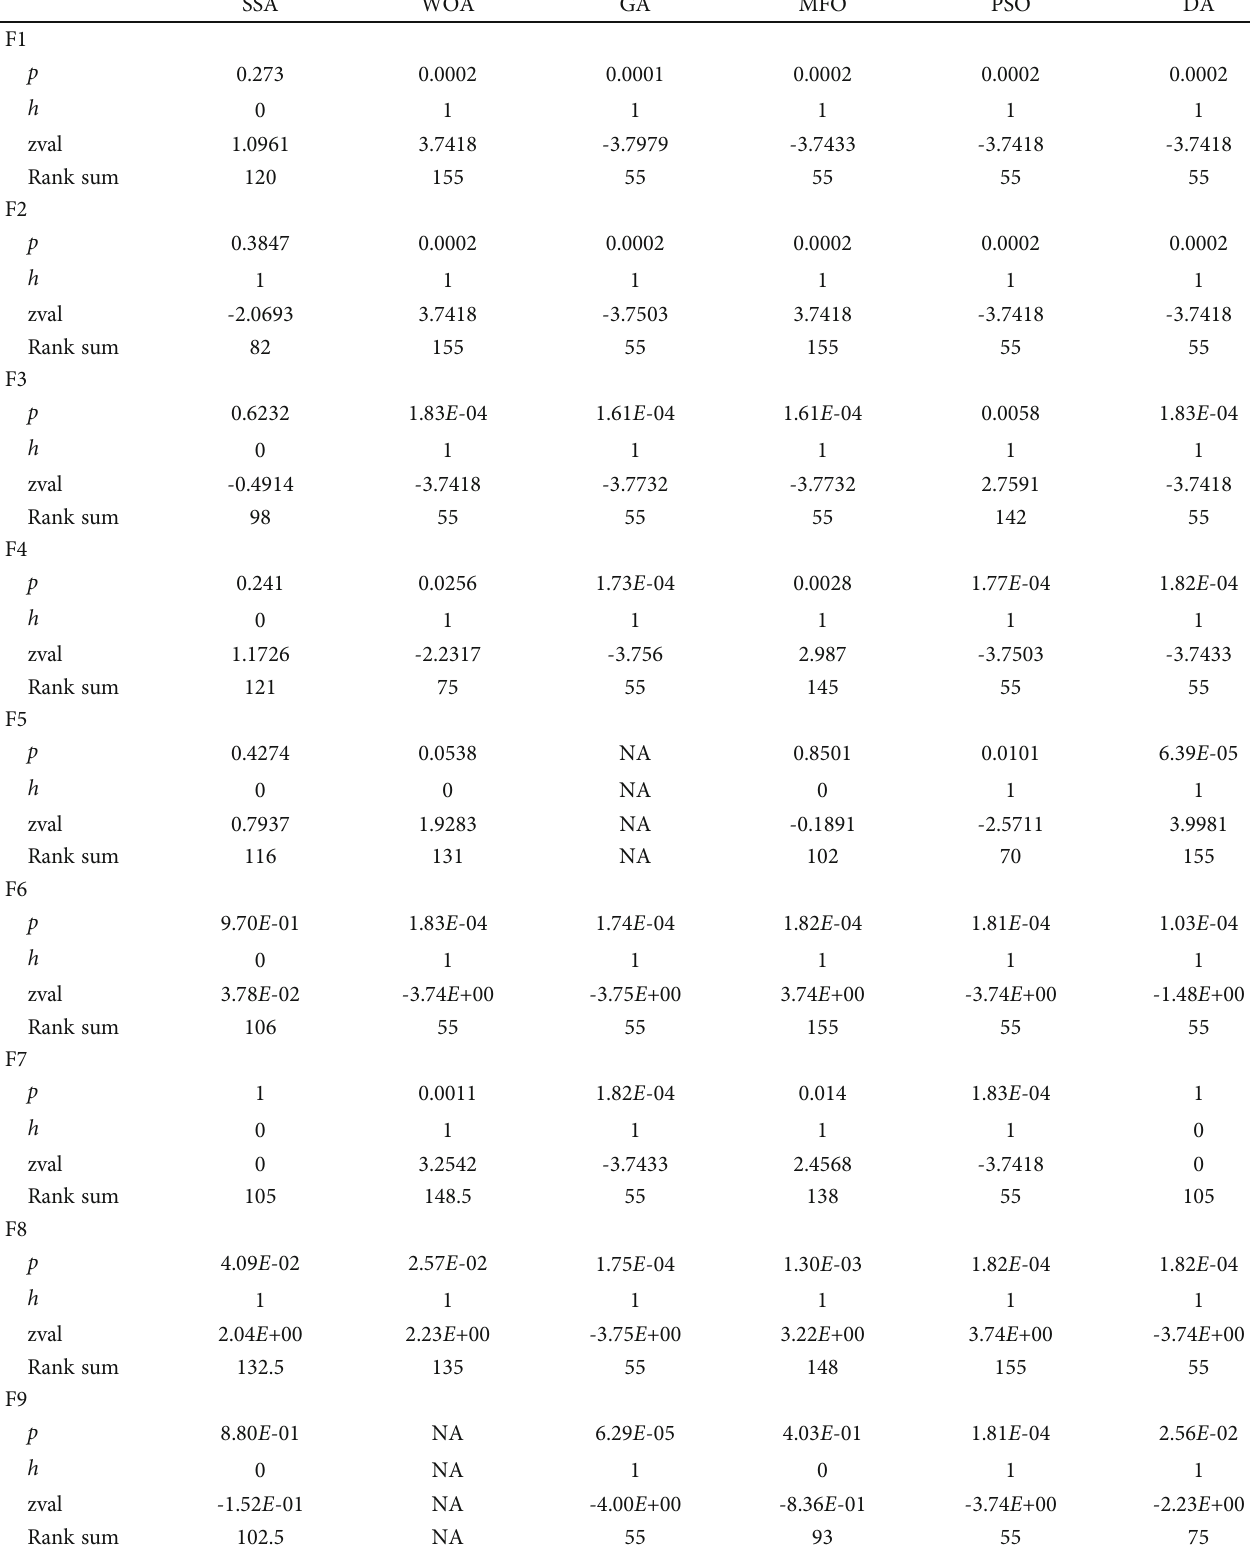
Table 2: MSSSA Wilcoxon rank sum test